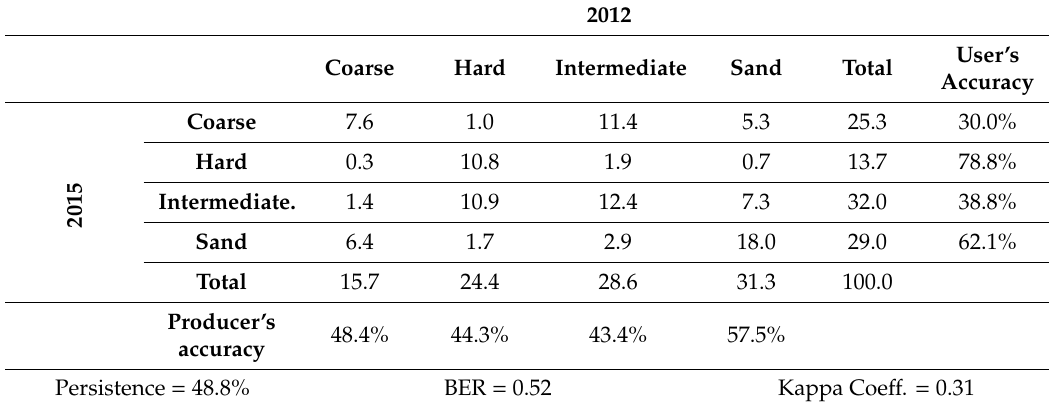
Table 10. Confusion matrix (percentage of pixels) for comparison between 2012 and 2015 habitat maps. (BER, balanced error